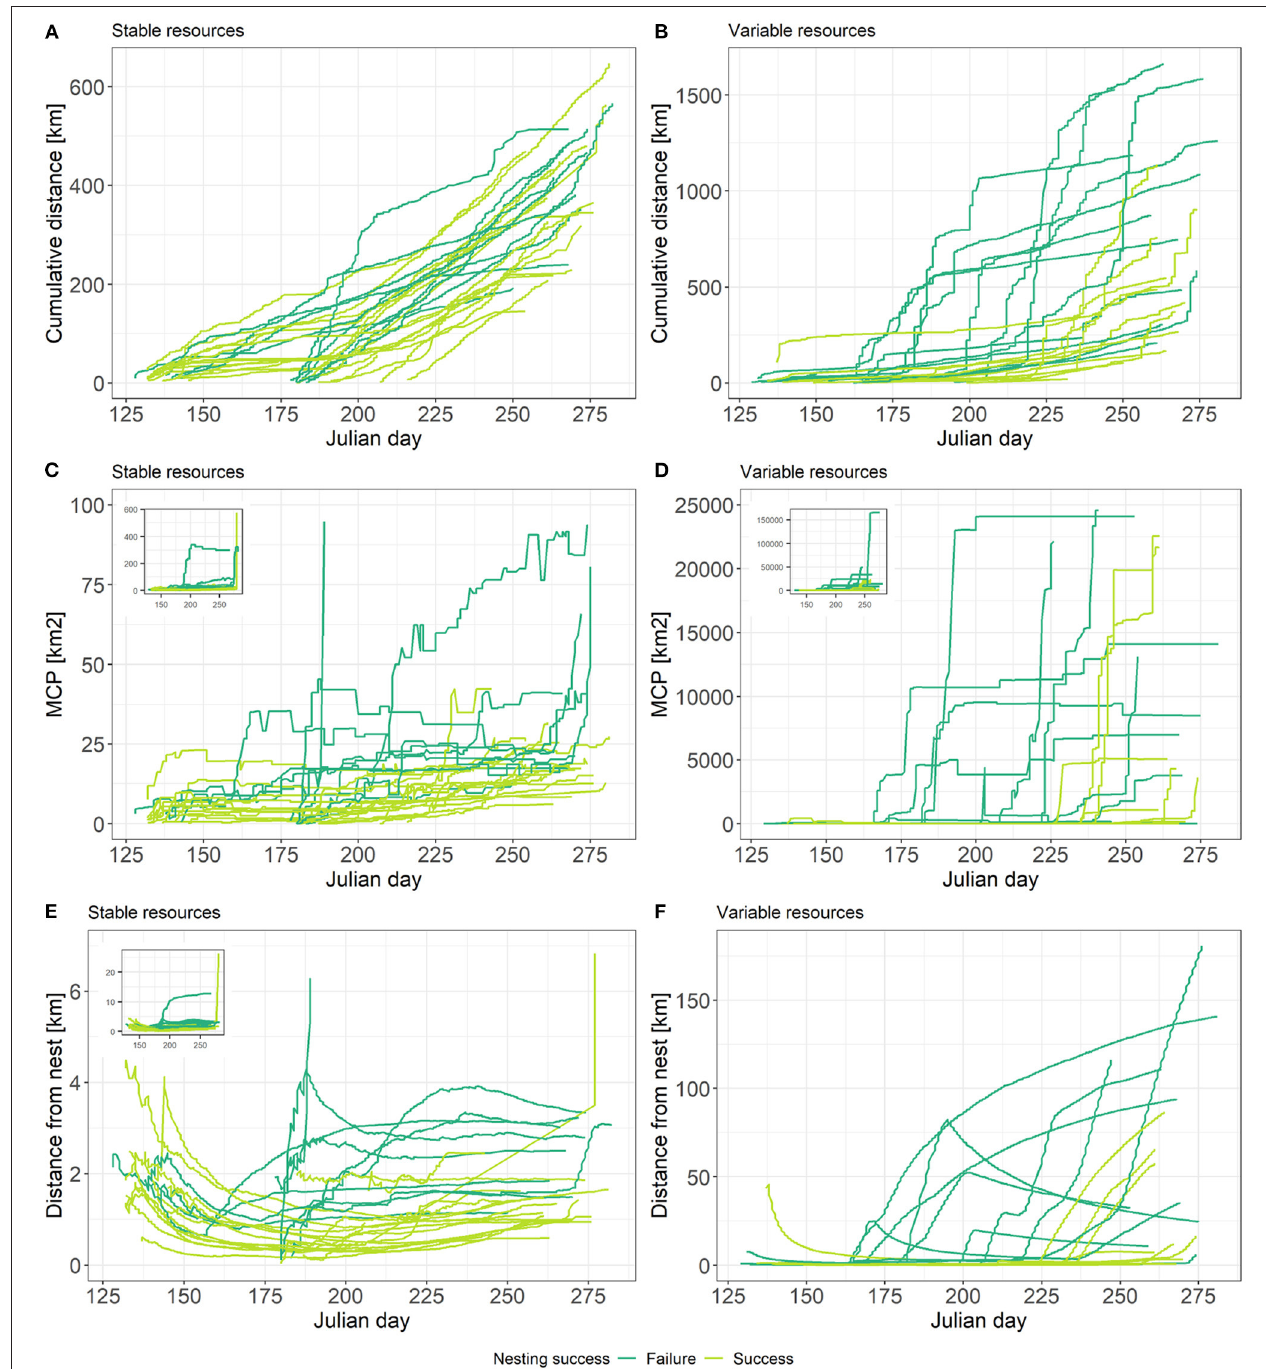
FIGURE 4 | (A) Cumulative distance as a function of Julian date for stable resources. (B) Cumulative distance as a function of Julian day for variable resources. (C) MCP as a function of Julian day for stable resources. (D) MCP as a function of Julian day for variable resources. (E) Nest distance as a function of Julian day for stable resources. (F) Nest distance as a function of Julian day for variable